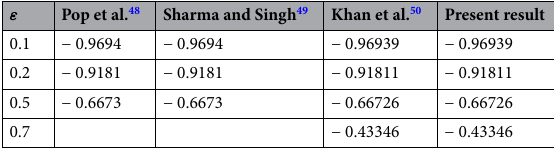
(cid:31) 0 with Pop et al. 48 , Sharma and β N r = = = =